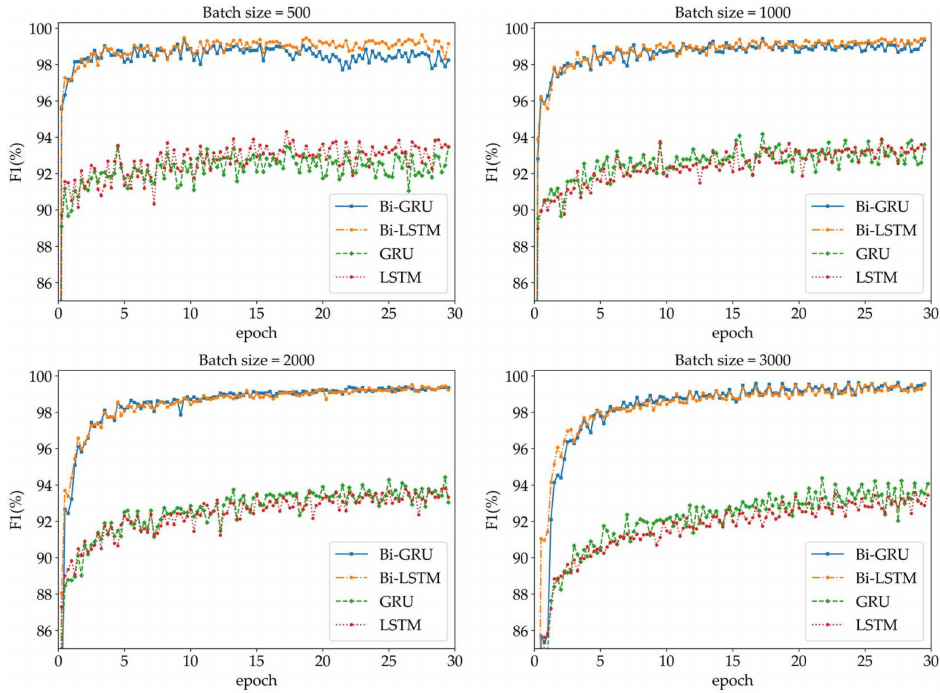
Figure 5. Comparison of di ff erent batch size hyperparameters for each neural network.